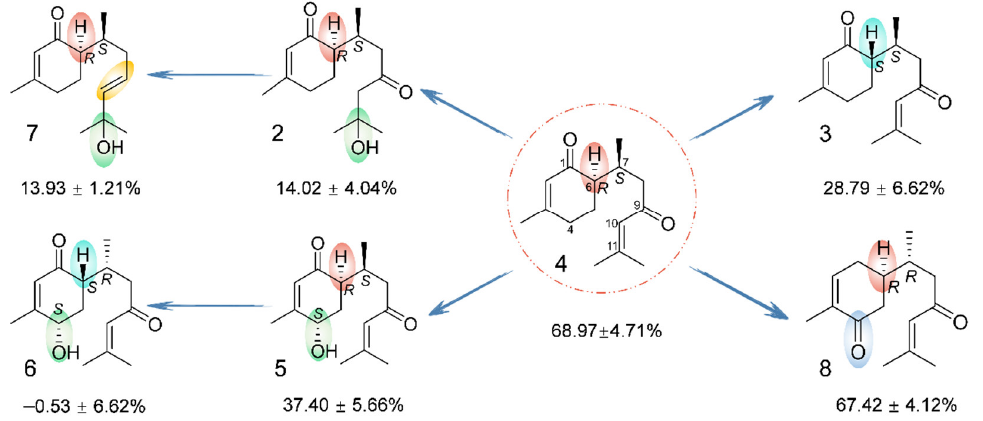
Figure 11. Summary of structure–activity relationships of bisabolane-type sesquiterpenoids. The numbers below the compounds indicate the maximum inhibition rates of the compounds against LPS-induced NO production.